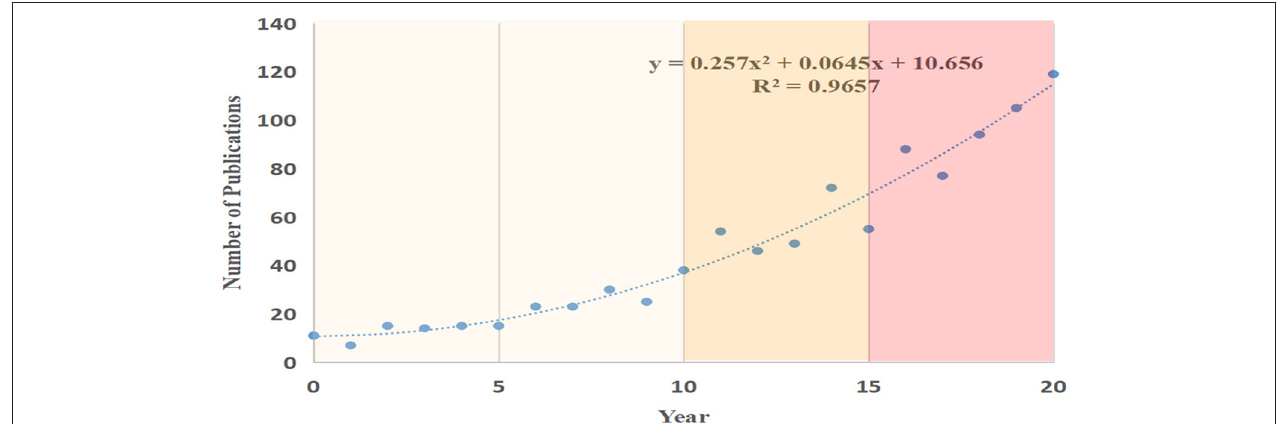
FIGURE 1 | The output of publications and growth trend in exercise-depression-teenager research.